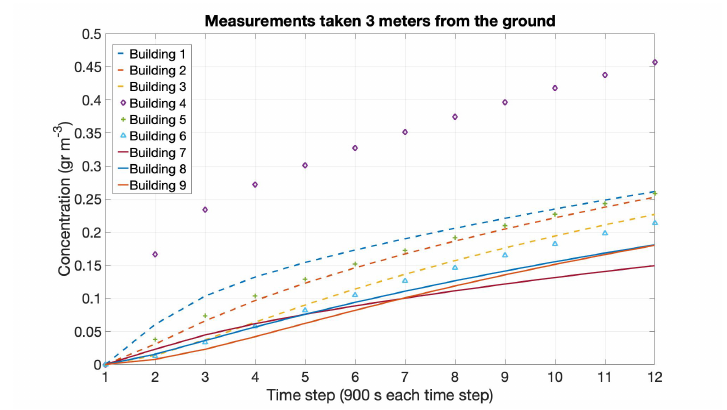
Figure 6. Concentration in the measurement points placed 3 m from the ground.